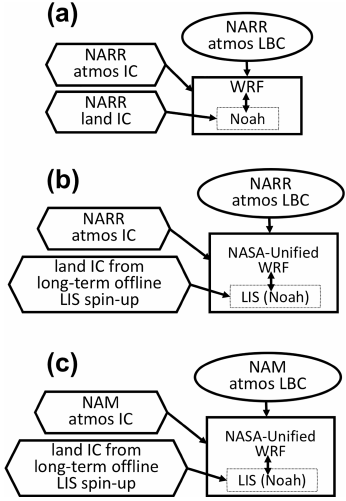
Figure 1. Illustration of the different (NU)WRF initialization meth- ods compared in this study: (a) a usual method, applied only on a 12km resolution grid, in which the land and atmospheric (atmos) initial conditions (IC) and lateral boundary conditions (LBC) are downscaled from a coarser model output from North American Re- gional Reanalysis (NARR). (b) The control runs on 12 and 4km resolution grids, in which the land IC are from long-term offline LIS spin-up at the same grid resolutions as NUWRF, forced by highly resolved atmospheric forcing and precipitation data; atmospheric IC and LBC are from NARR. (c) Same as (b) , except that atmospheric IC and LBC are from the North American Mesoscale Forecast Sys- tem (NAM). Table 1 summarizes all NUWRF simulations in this study including the corresponding initialization methods illustrated